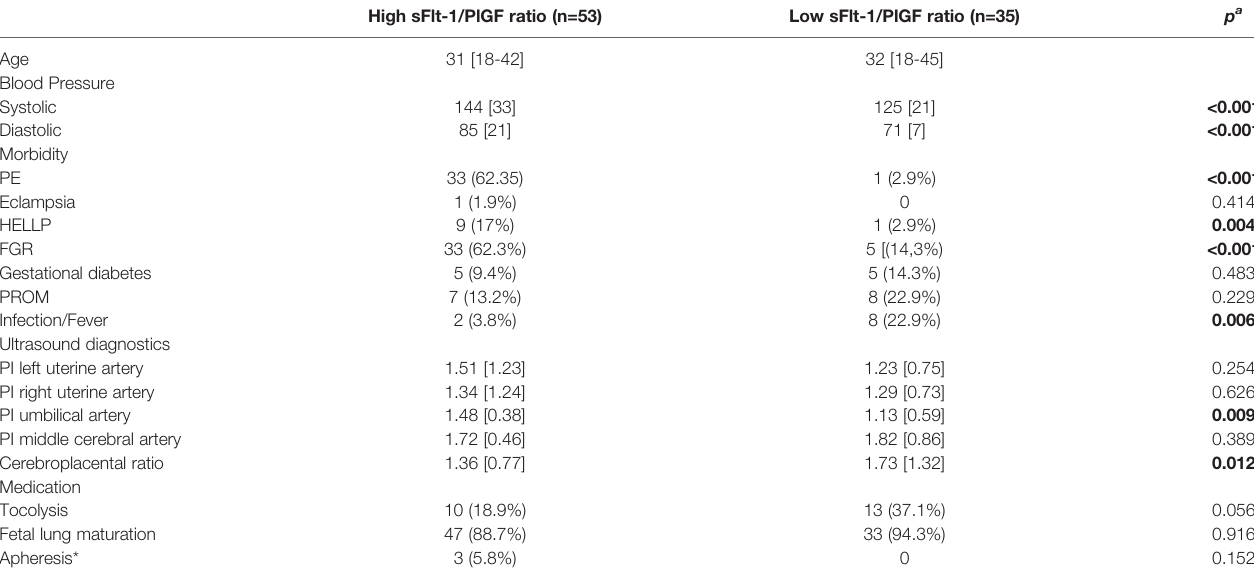
TABLE 1 | Maternal